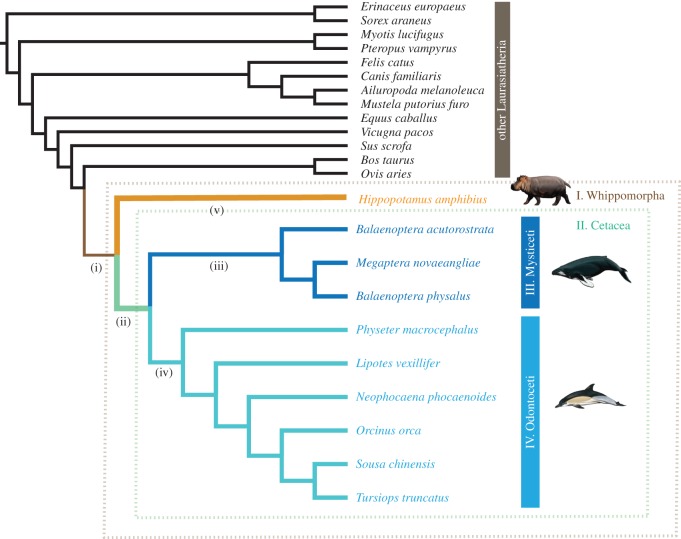
Evolutionary relationships among laurasiatherian mammals as used in molecular evolution analyses. The four clades tested for divergent selection are shown in colour and numbered in uppercase: (I) Whippomorpha (Hippopotamidae + Cetacea); (II) Cetacea; (III) Mysticeti and (IV) Odontoceti. Branches tested for positive selection are numbered in lowercase: (i) Whippomorpha (Hippopotamidae + Cetacea); (ii) Cetacea; (iii) Mysticeti; (iv) Odontoceti and (v) hippo.